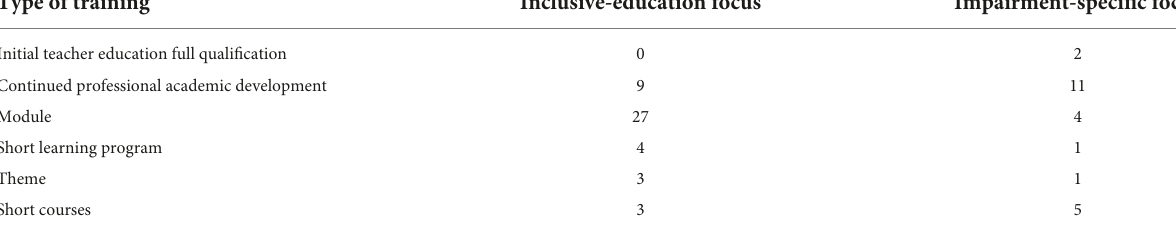
TABLE 1 Teacher education programs with impairment